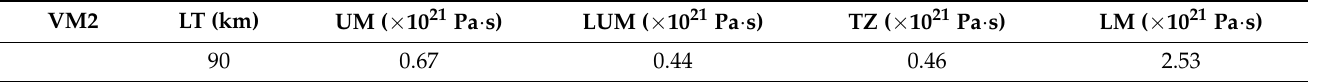
Table 1. Glacial and hydro-isostatic adjustment (GIA).